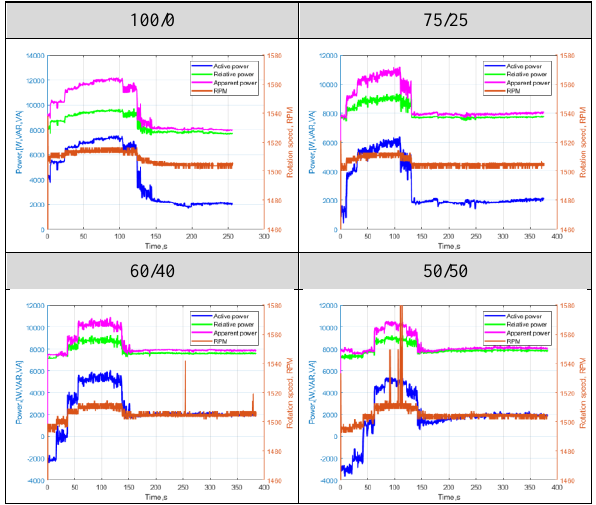
Fig. 6. Course of electrical powers and engine rotational speed at supply of different gas mixture